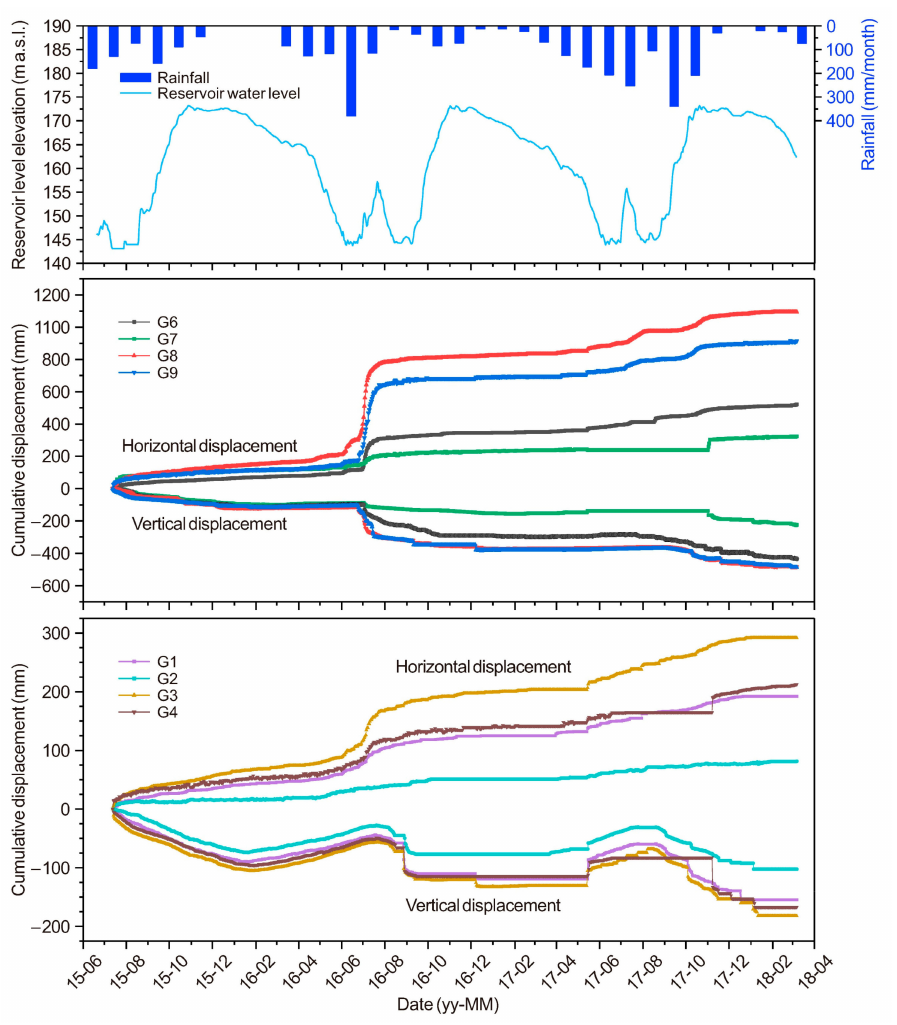
Figure 11. Cumulative displacements measured by GNSS monitoring, and the associated reservoir water level and rainfall. Table 3. Yearly and total deformation of typical surface